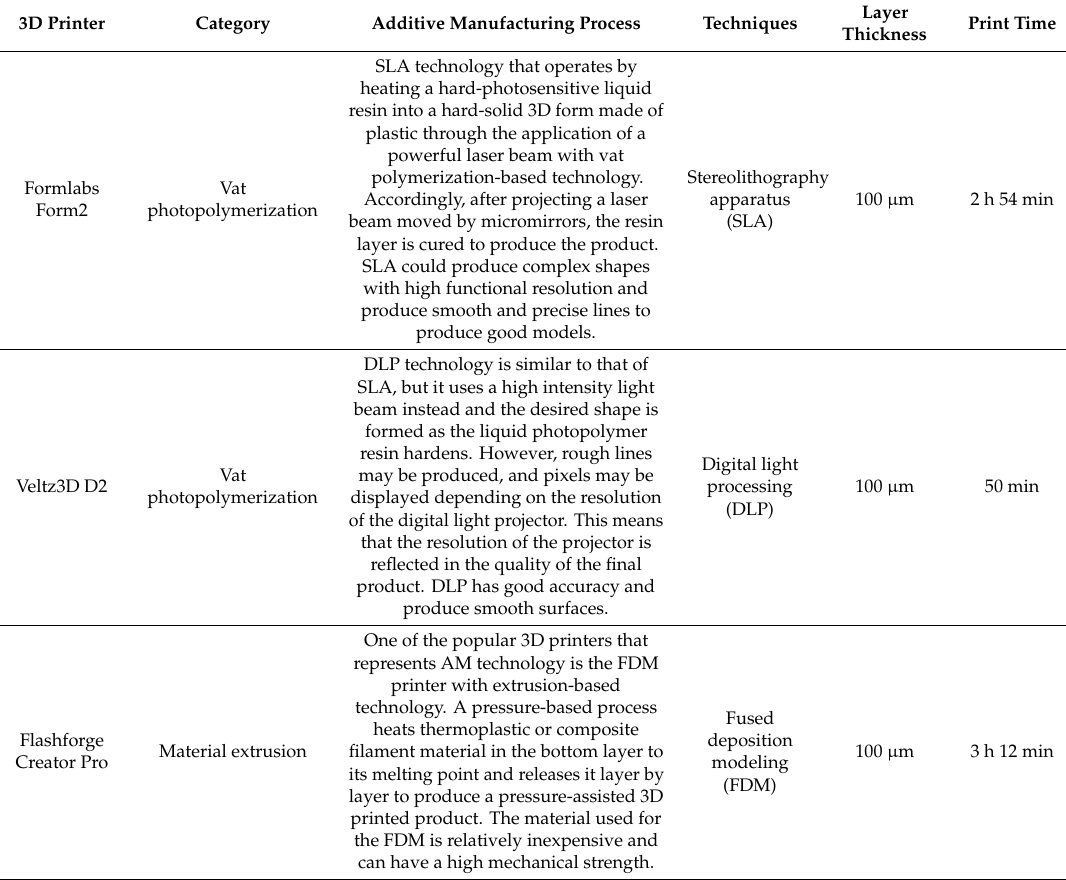
Table 2. Characteristics of 3D